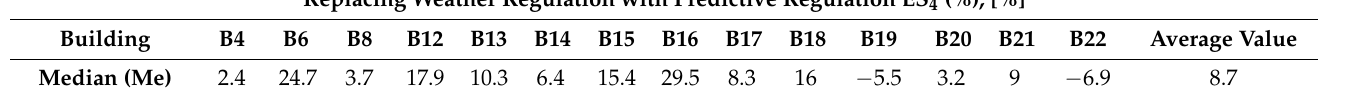
Table 12. Energy savings as a result of replacing weather control with Egain Edge predictive control (after thermal improvement) ES 4 (%),